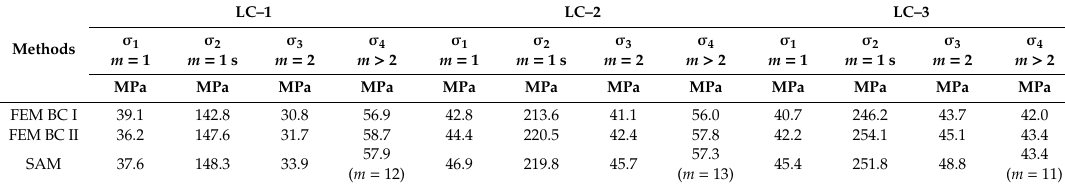
Table 4. Comparison of buckling stresses for considered buckling modes.